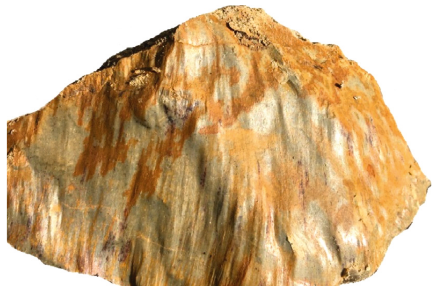
Figure 5: Friction mirror surface of fault gouge.